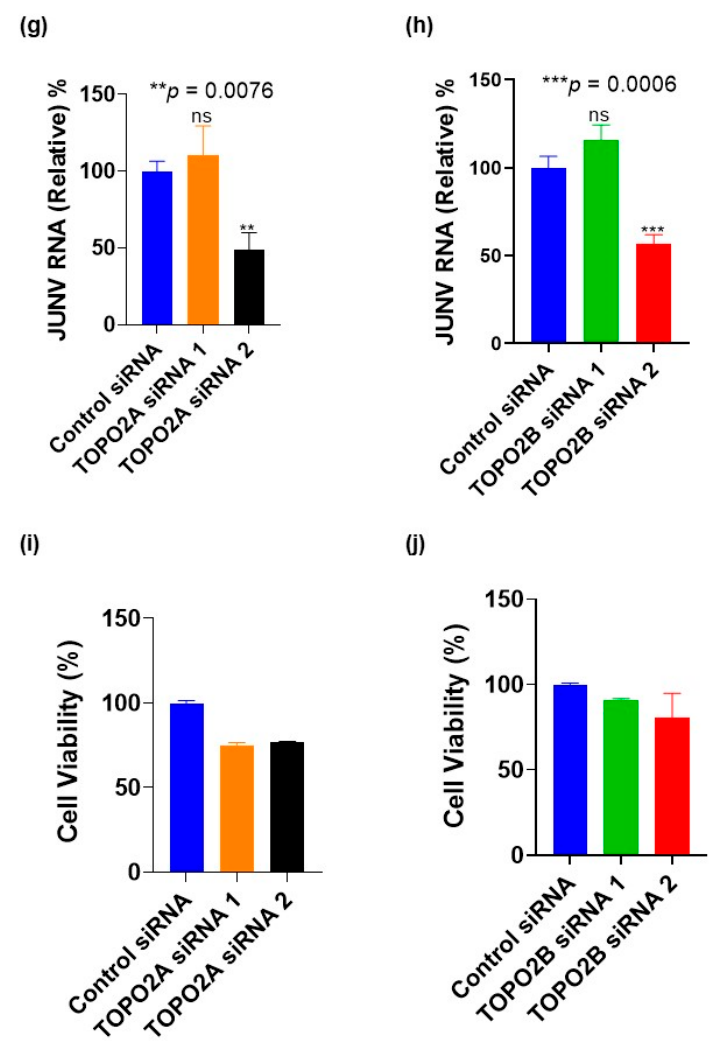
Figure 7. Knockdown of topoisomerase II α and II β restricts JUNV replication. Representative immunoblot images of topoisomerase II α ( a ) and II β ( b ) expression in A549 cells treated with control or topoisomerase II α - or II β -targeting siRNAs. β -Actin was used as an internal control. A549 cells were seeded in 24-well plates and transfected with the indicated siRNAs simultaneously. The medium was replaced 3 days post-seeding, and the cell lysate was collected 2 days later. Intracellular RNA levels of topoisomerase II α ( c ) and II β ( d ) after siRNA knockdown. A549 cells were seeded and transfected as described in ( a , b ). Intracellular RNA was collected for qPCR 3 days post-seeding. Impact of topoisomerase II α siRNA ( e ) and II β siRNA ( f ) knockdown on JUNV replication. A549 cells were seeded and transfected with the indicated siRNAs in triplicate as described above. The cells were infected 3 days post-seeding, and the virus was washed out after 1 h of adsorption. The viral supernatants were collected at 2 days post-infection (d.p.i). JUNV GPC RNA levels in the supernatants were quantified with qPCR. The intracellular RNA was also collected 2 d.p.i to evaluate the impact of topoisomerase II α siRNA ( g ) and II β siRNA ( h ) knockdown on intracellular RNA levels of JUNV GPC by qPCR. Effect of topoisomerase II α siRNA ( i ) and II β siRNA ( j ) knockdown on A549 cell viability. Cells were seeded and transfected with the indicated siRNAs in triplicate as described above. Media was replaced on the 4th day of the experiment and cell viability was measured at 2 days after the media was replaced. Data are presented as means ± SD and are representative of two independent experiments. P values are provided in the graphs. Values in control siRNA wells were set to 100%.